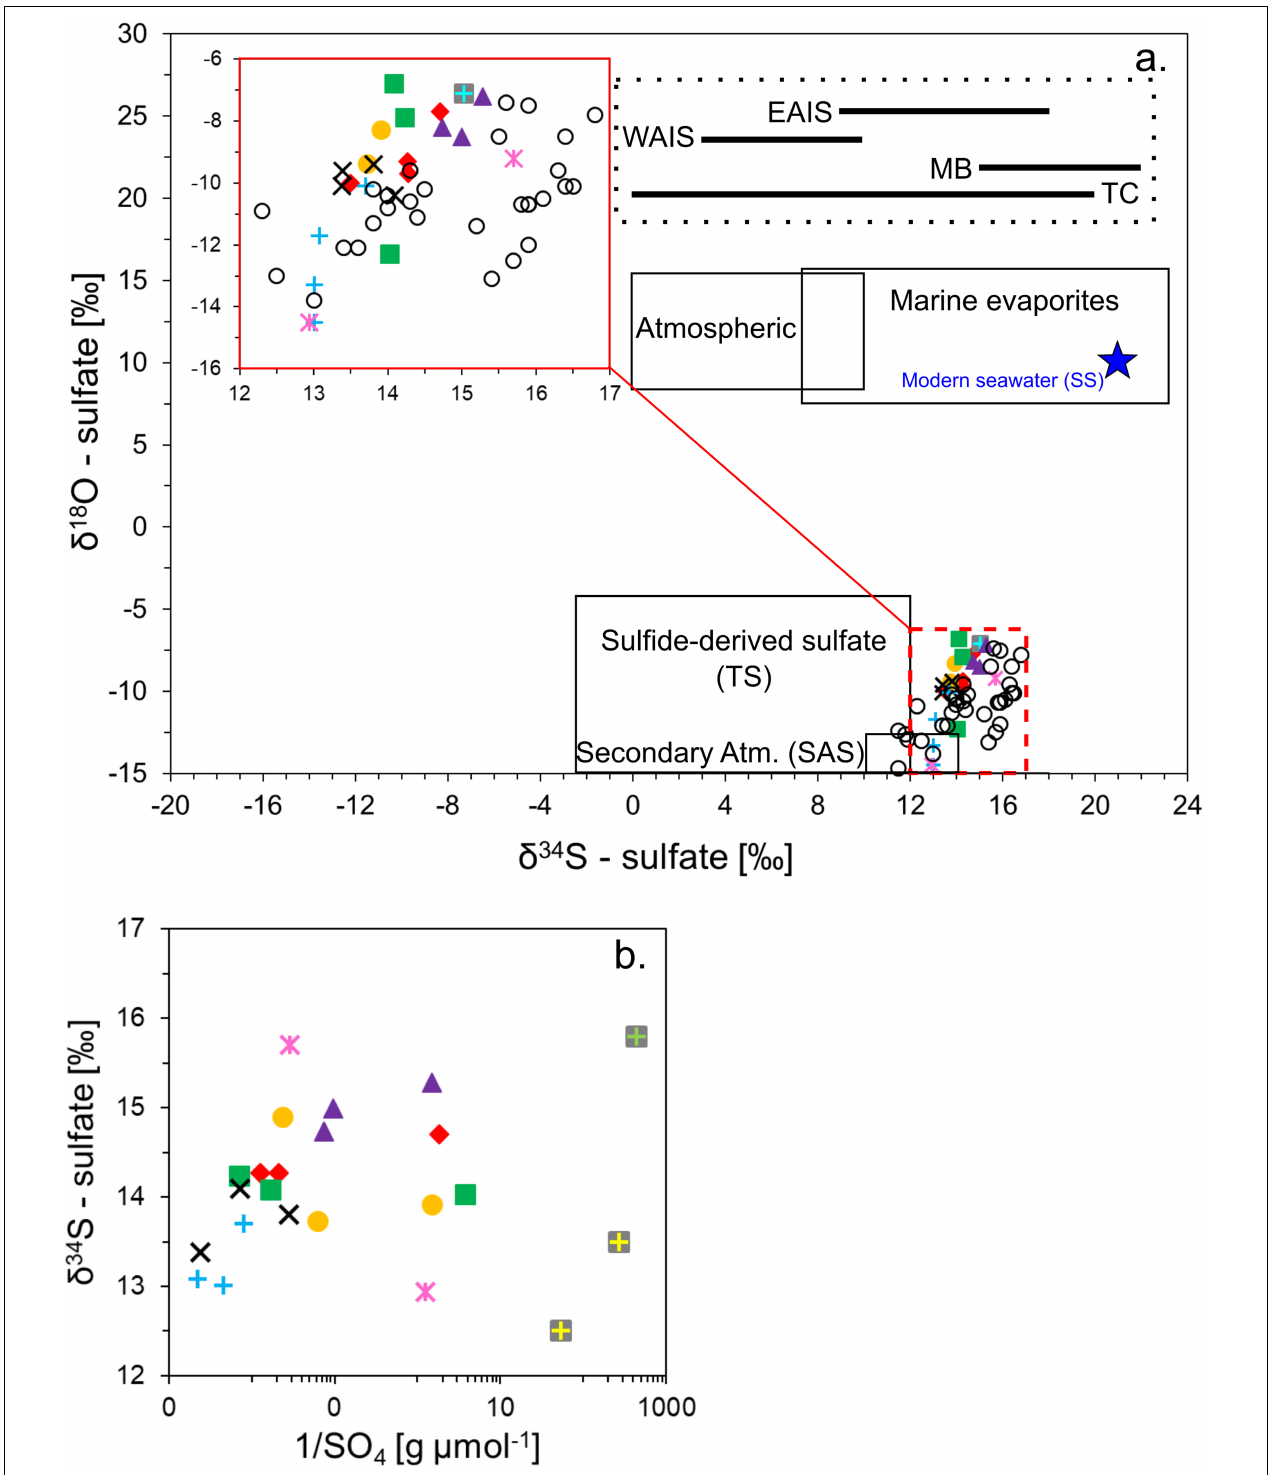
FIGURE 7 | Isotopic composition of SO 42 - (a) and the variation of δ 34 S with inverse sulfate concentrations (b) . The shapes and colors representing the different sampling locations correlate with the key in Figure 2 . The clear circles represent MB11 samples (Asgard Tills) from the McMurdo Dry Valleys (Bao and Marchant, 2006). The solid red box shows the distribution of the samples at a higher resolution. The solid and dotted black boxes represent potential SO 42 - sources and the blue star is the SO 42 - isotopic composition of modern seawater (Holser and Kaplan, 1966; Faure and Felder, 1981; Calhoun and Chadson, 1991; Legrand et al., 1991; Alexander et al., 2003; Pruett et al., 2004; Jonsell et al., 2005; Bao and Marchant, 2006; Baroni et al., 2008; Tostevin et al., 2014).